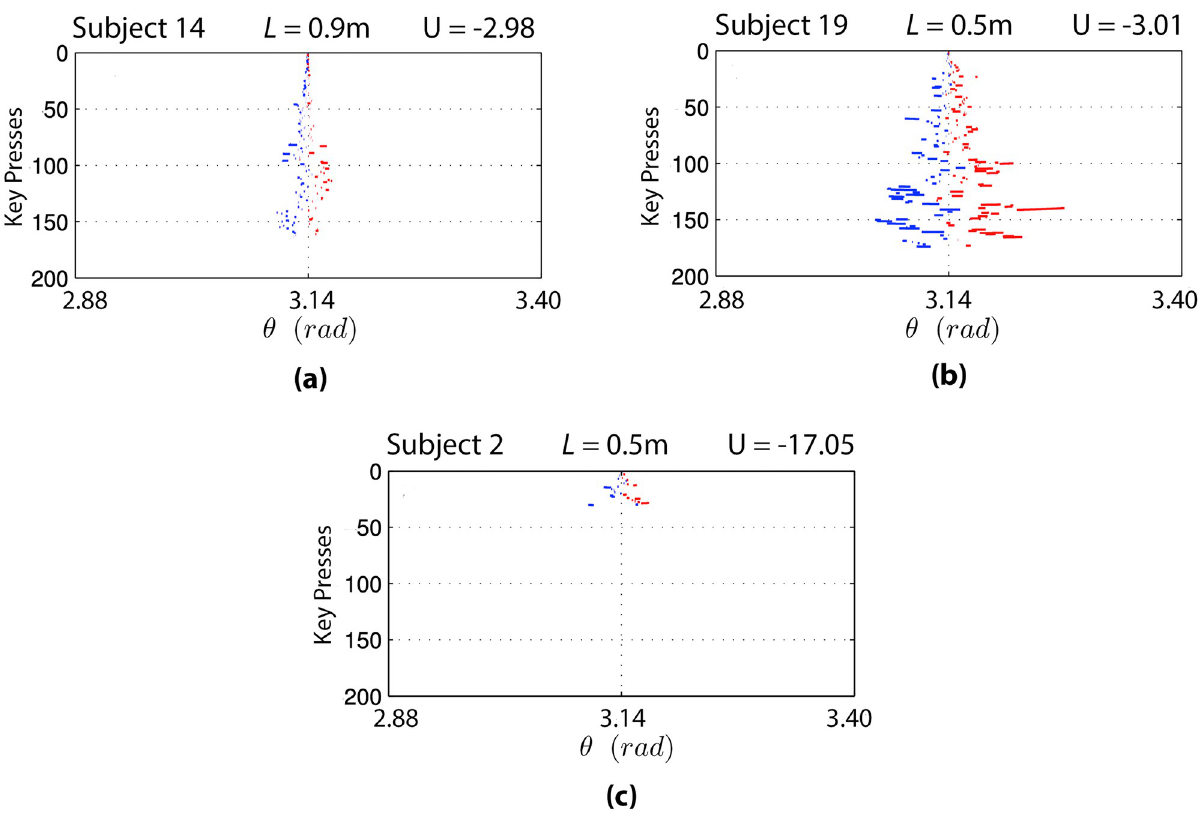
Fig 10. Distribution of key presses in the balancing region for three trials and distance traveled by the pendulum during the key presses. Blue segments represent actions that push the pendulum in the clockwise direction, red segments indicate actions that steer the pendulum towards the anti- clockwise direction. Key presses (“balancing episodes”) are reported subsequently from the top to the bottom of the plot. In (a) and (b) the key presses of two skilled participants are reported, where in (c) the key presses of a less skilled participant is shown.